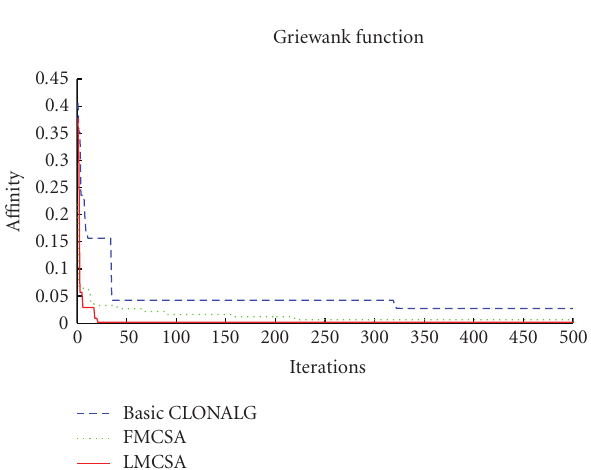
Figure 13: Convergent performances on Griewank’s function ( f 11).